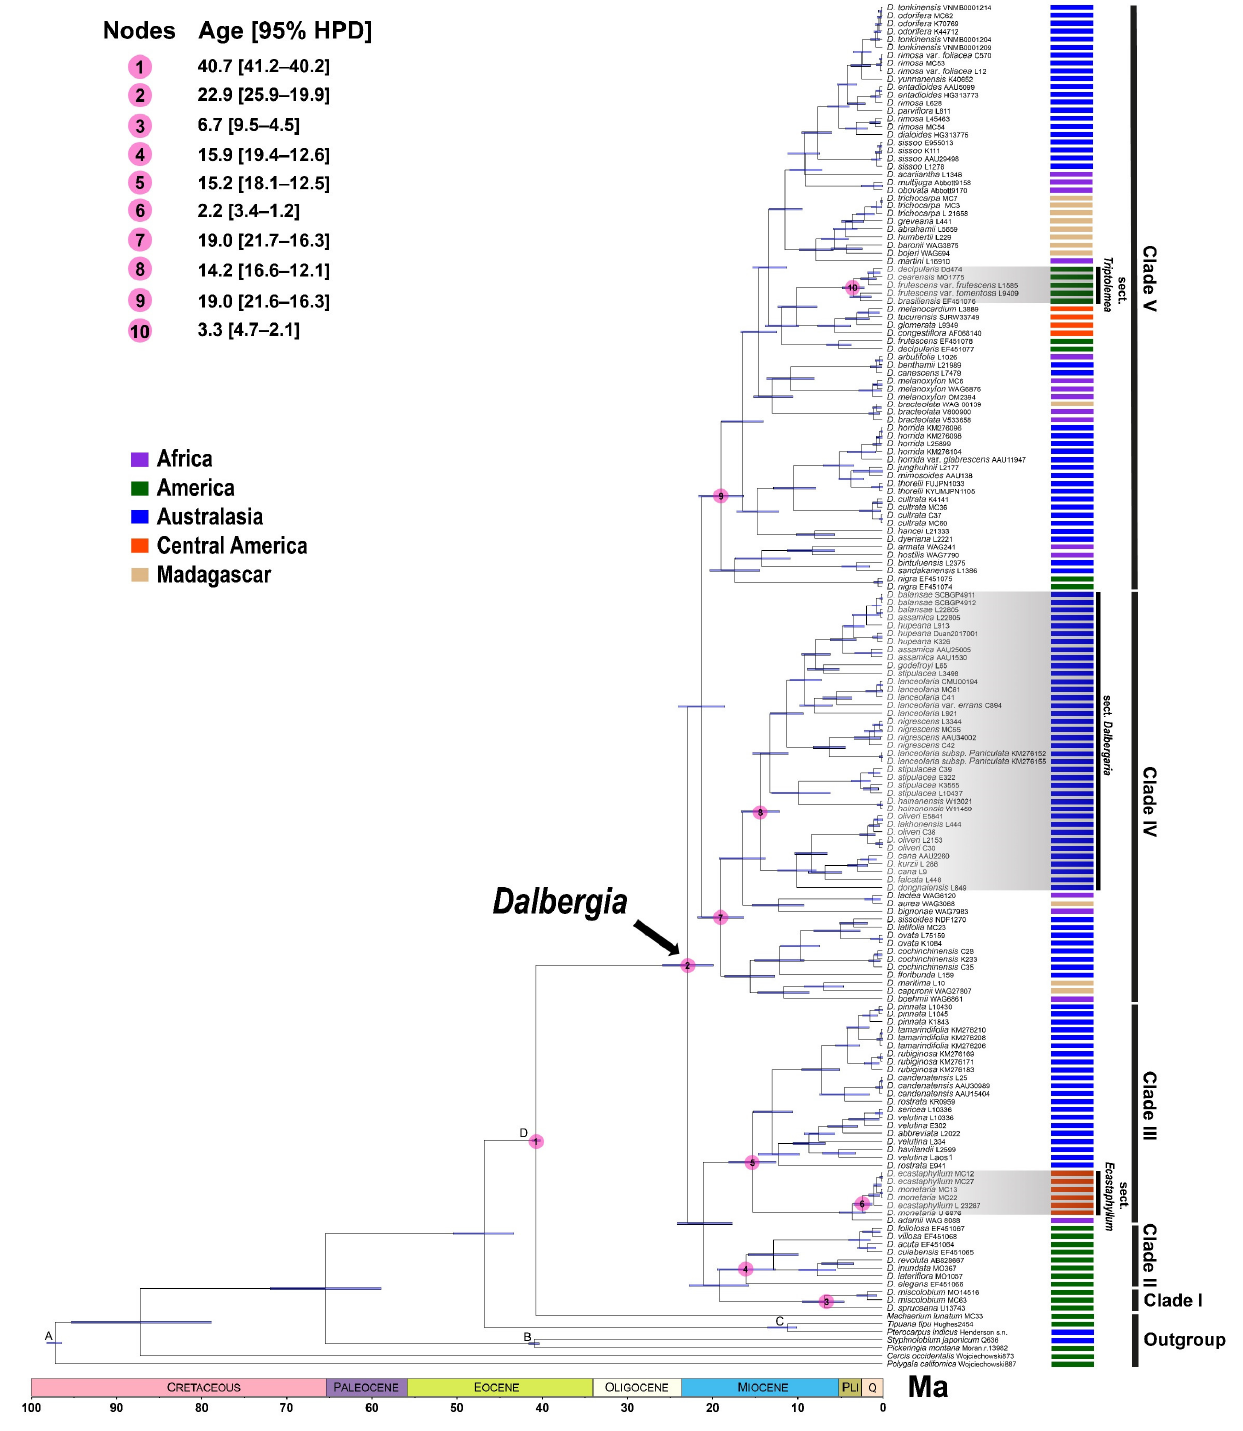
Figure 2. Chronogram of Dalbergia inferred from the BI tree using BEAST. The shaded blue horizontal bars show 95% HPD for the divergence times. Labels A–D correspond to the calibration points used (see Table 1 for details). Nodes of interests are marked as 1–10.